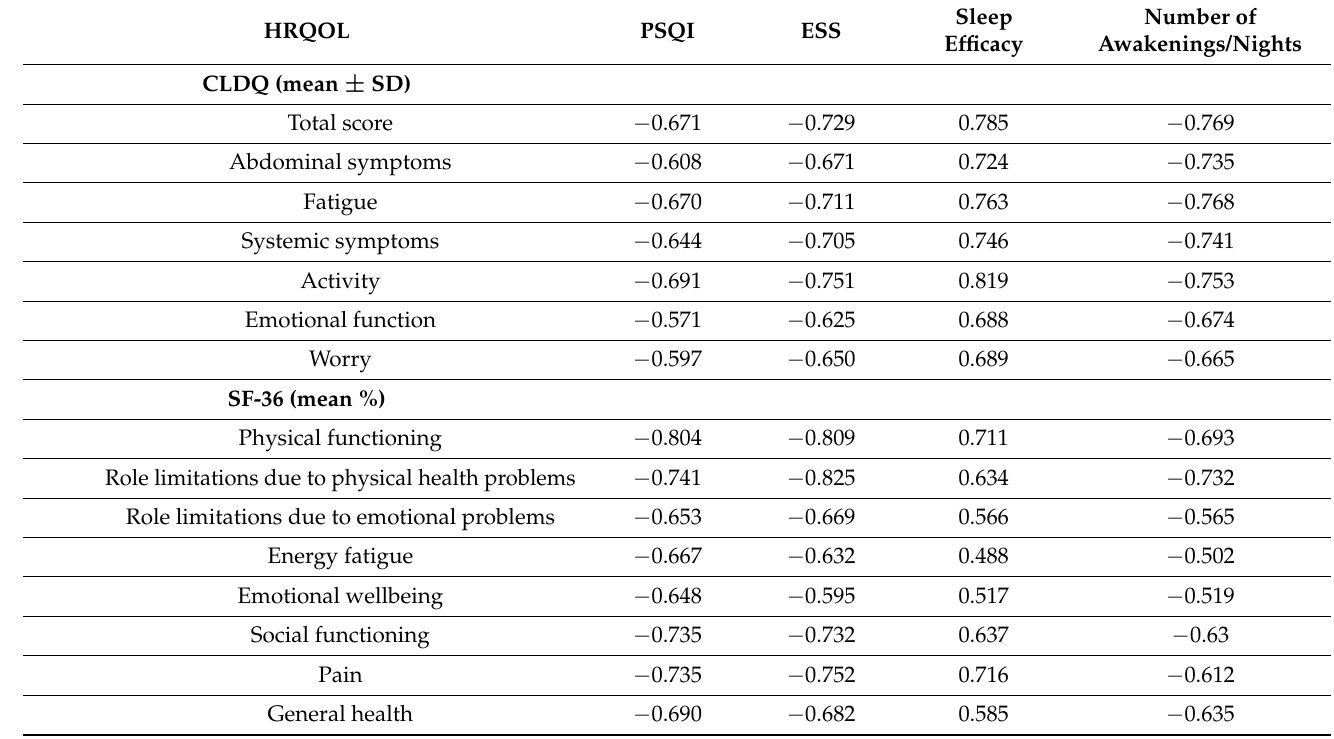
Table 8. Correlations between sleep assessment and HRQOL among enrolled